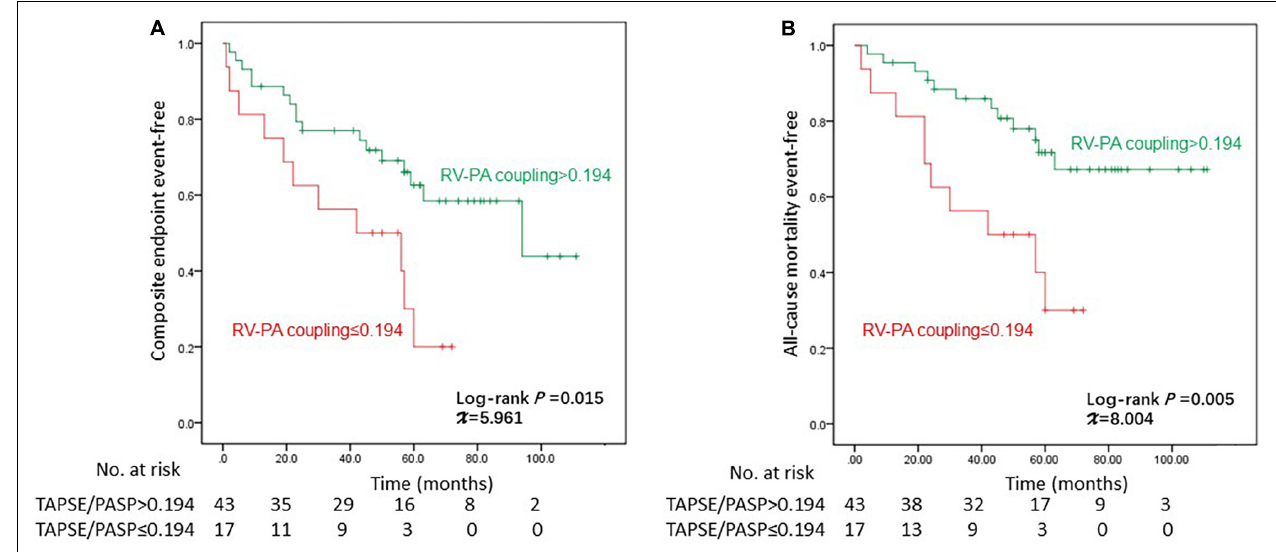
FIGURE 3 | Kaplan–Meier curves for the probability of (A) composite endpoint and (B) all-cause mortality. PASP, pulmonary artery systolic pressure; TAPSE, tricuspid annular plane systolic excursion; RV-PA, right ventricle to pulmonary artery.